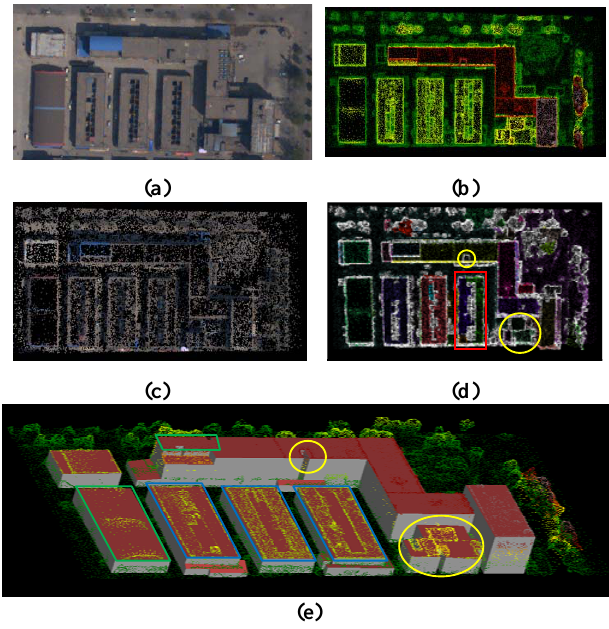
Figure1. Result of segmentation and reconstruction (a)image of test area (b) point clouds by elevation (c)point clouds by color (d)result of segmentation (e)result of